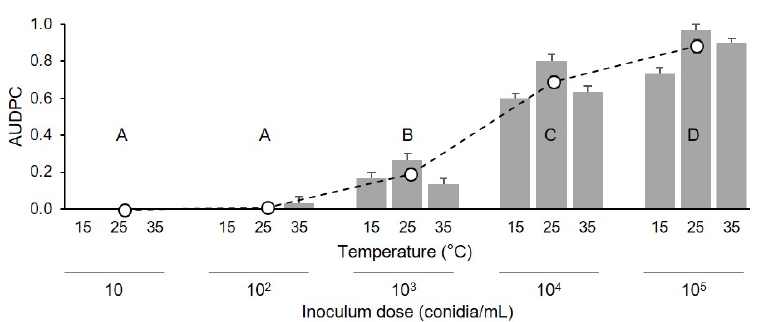
Figure 5. Values of the area under the disease progress curve (AUDPC, dimensionless) for grapevine berries that were injured and then drop-inoculated with conidia of Coniella diplodiella at 5 inoculum doses (10, 10 2 , 10 3 , 10 4 , or 10 5 conidia/mL), and then incubated at 3 temperatures (T: 15, 25, or 35 ◦ C) for 24 h (experiment 2). AUDPC data were standardized by dividing the original AUDPC values by the time considered for their calculation, i.e., 9 d. Bars indicate means ( ± SE) of 3 replicates, with 15 berries per replicate. White dots are the means ( ± SE, n = 45) of the 3 incubation temperatures for each inoculum dose; letters show comparisons of the latter means as determined by Tukey’s HSD test, with p = 0.05.